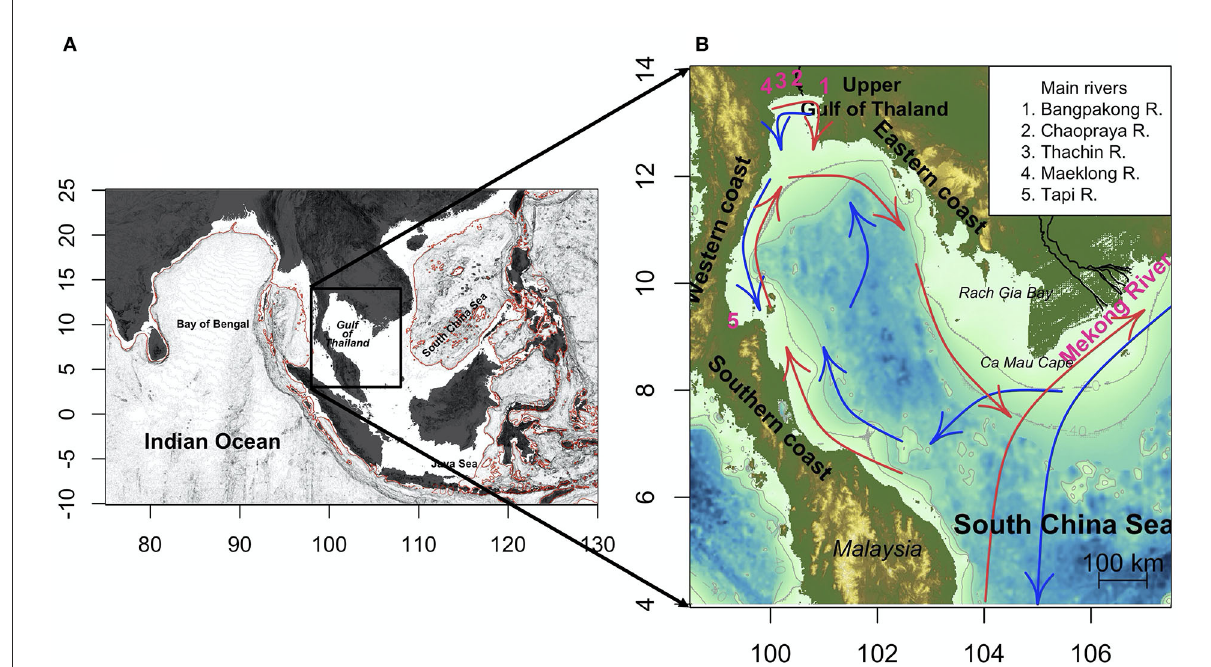
FIGURE1 Location (A) and topography (B) of the Gulf of Thailand. The gray contour lines in (B) denote bathymetry at 20 and 40 meters, blue and red vectors indicate the ocean circulation during northeast monsoon and southwest monsoon, respectively (adapted from Buranapratheprat and Bunpapong,